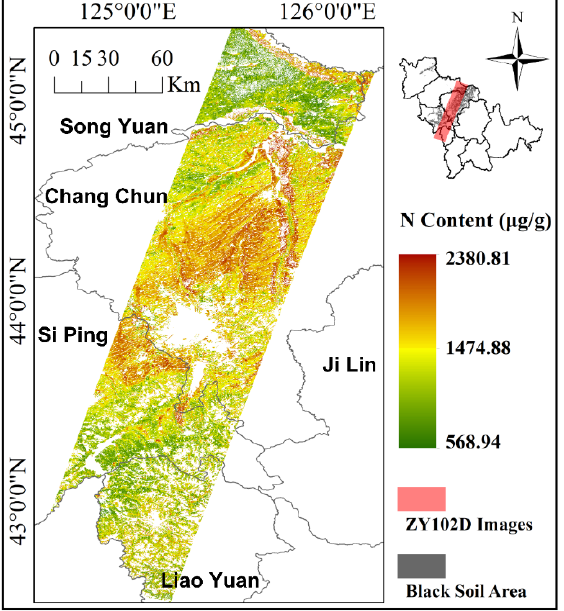
Figure 12. The spatial distribution of the estimated topsoil N content of the farmlands of the Jilin black soil belts in northeast China (The “Lower” and “Upper” of N content refer to the 95% confidence interval).